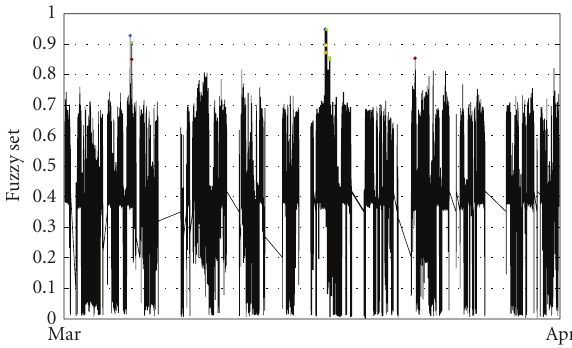
Figure 15: Fuzzy set for the month of March 2011.